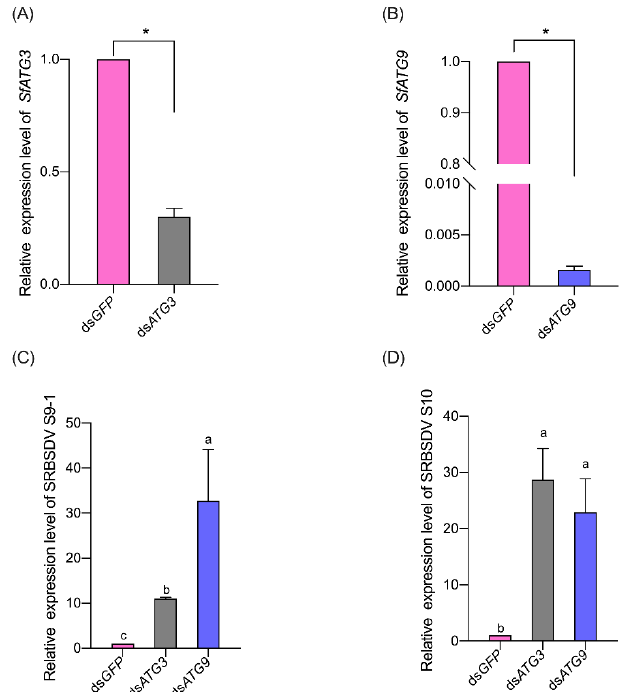
Figure 4. Effects of silencing SfATG3 or SfATG9 on the expression of SfATG3 ( A ) or SfATG9 ( B ) genes and of SRBSDV S9-1 ( C ) and S10 ( D ). Expression was normalized to the levels of SfEF1 α that serves as the internal standard. The relative mRNA levels of autophagy-related genes and SRBSDV S9-1 and S10 in ds GFP -treated group were arbitrarily set to 1. Bars (mean ± S.E.) with different letters indicate significant differences (Tukey test, p < 0.05). Asterisk indicates a significant difference at the 0.05 level between the ds GFP -treated group and the ds ATG3 or ds ATG9 -treated group ( t -test). Table 3. Effects of silencing SfATG3 or SfATG9 on SRBSDV acquisition and inoculation.